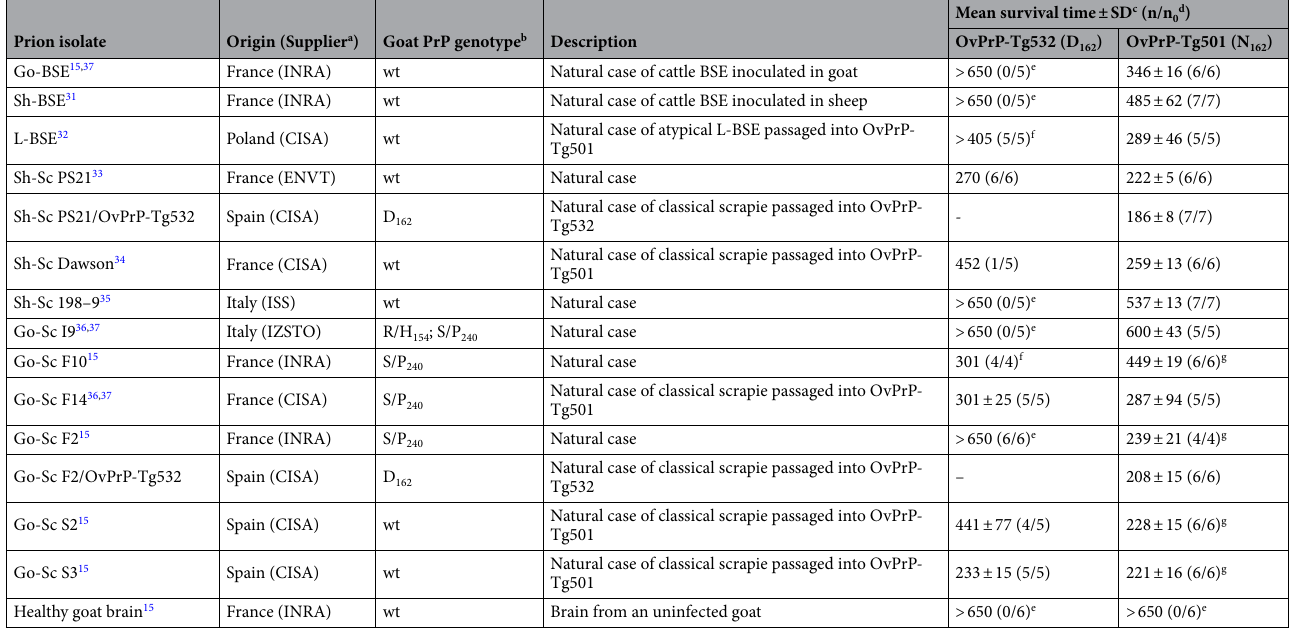
Table 1. Prion transmission in OvPrP-Tg532 and OvPrP-Tg501 mice. a CISA, Centro de Investigación en